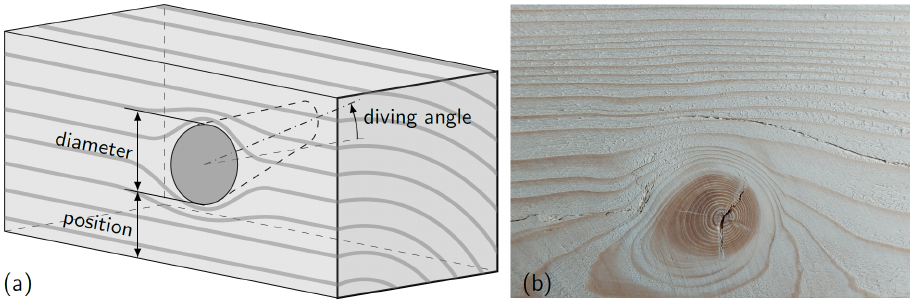
Figure 5. ( a ) Schematic diagram of the vicinity of a knot, ( b ) Test specimen containing a knot after failure; fractures reveal the complex stress distribution around the